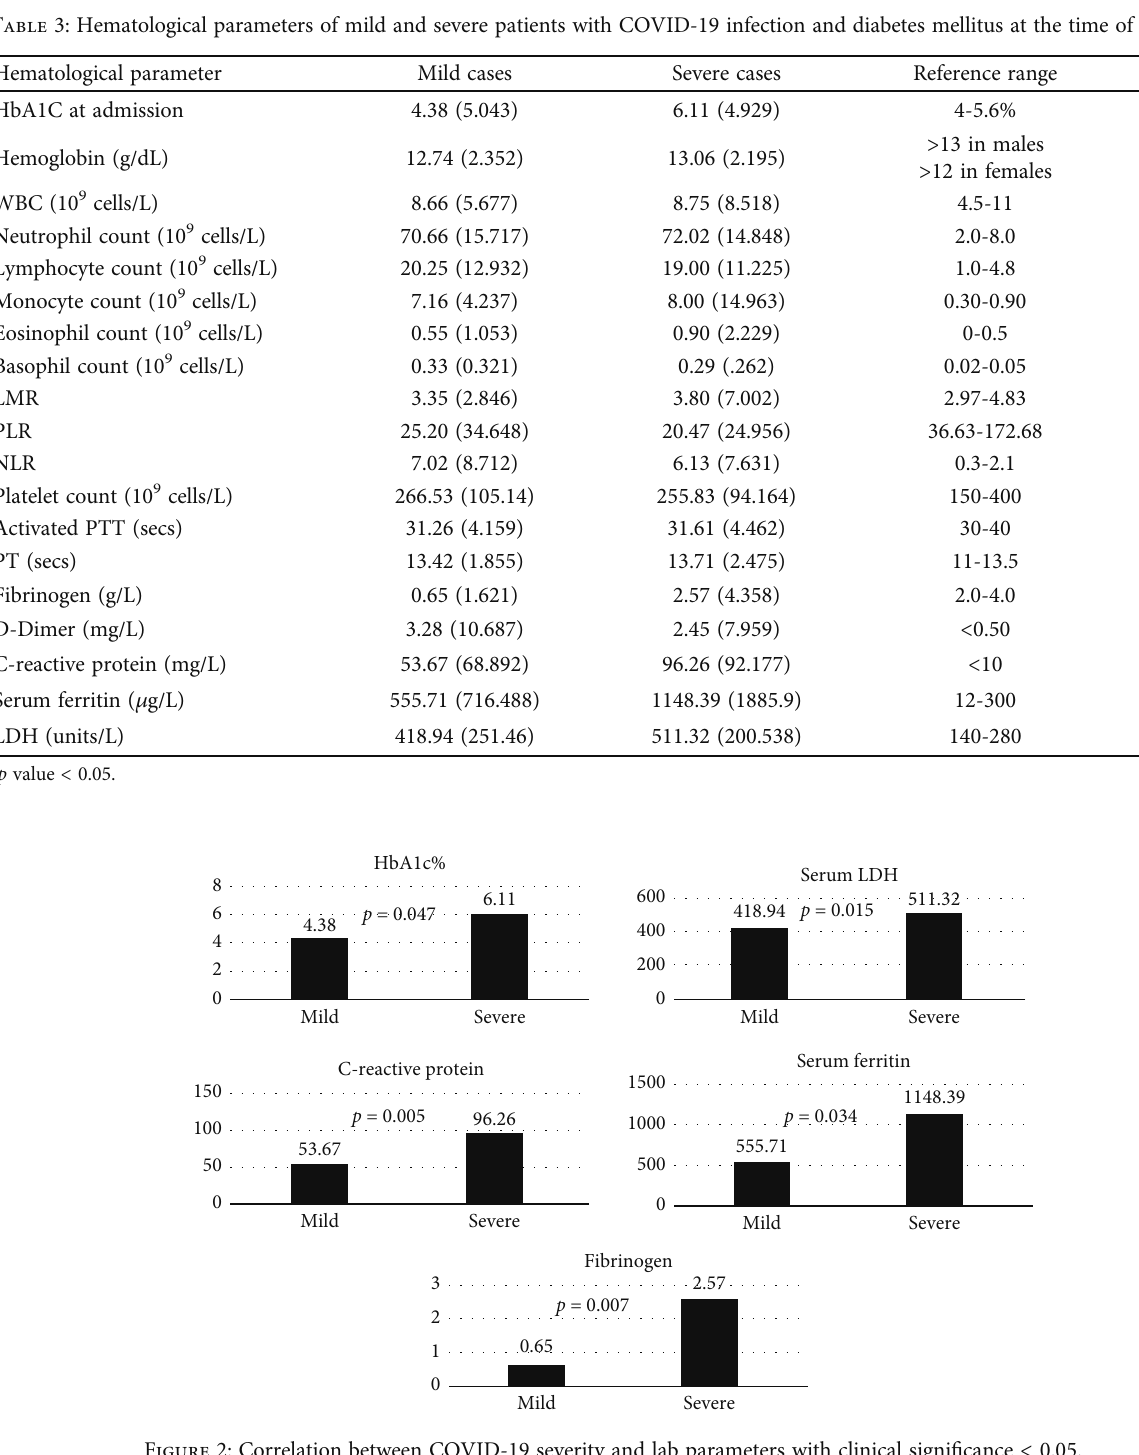
Figure 2: Correlation between COVID-19 severity and lab parameters with clinical signi fi cance <